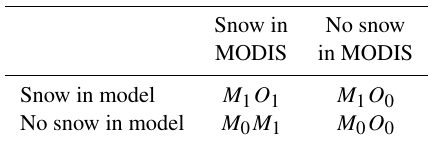
Table 5. Table of possible pixel states in a binary classifica- tion scheme for the validation of seasonal MODIS ( O ) and mod- elled ( M ) snow